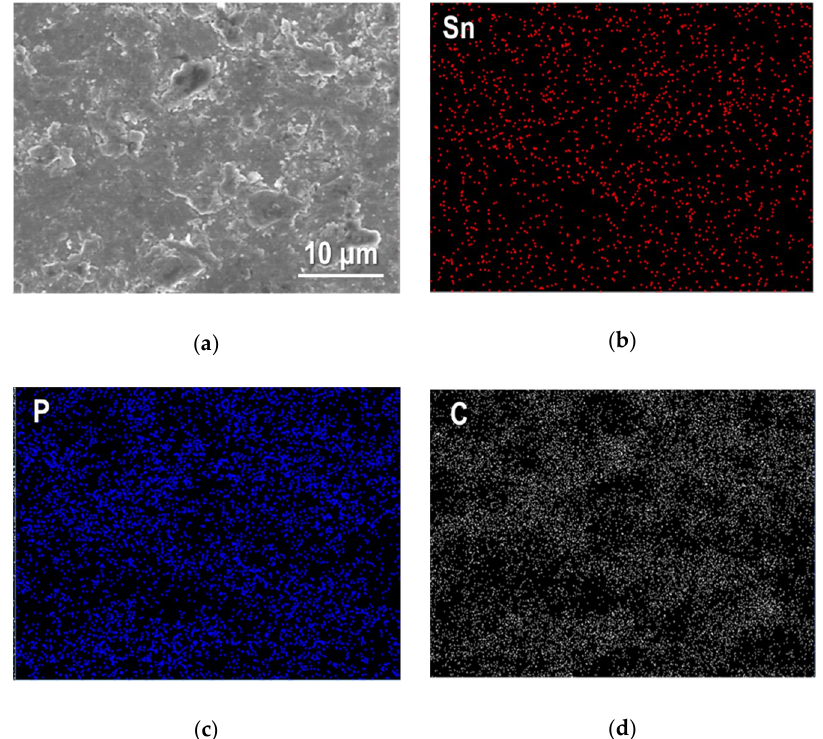
Figure 5. ( a ) SEM image of the broader surface of the Sn 4 P 3 /C composite film. Corresponding element mapping for Sn, P and C are shown in ( b ), ( c ) and ( d